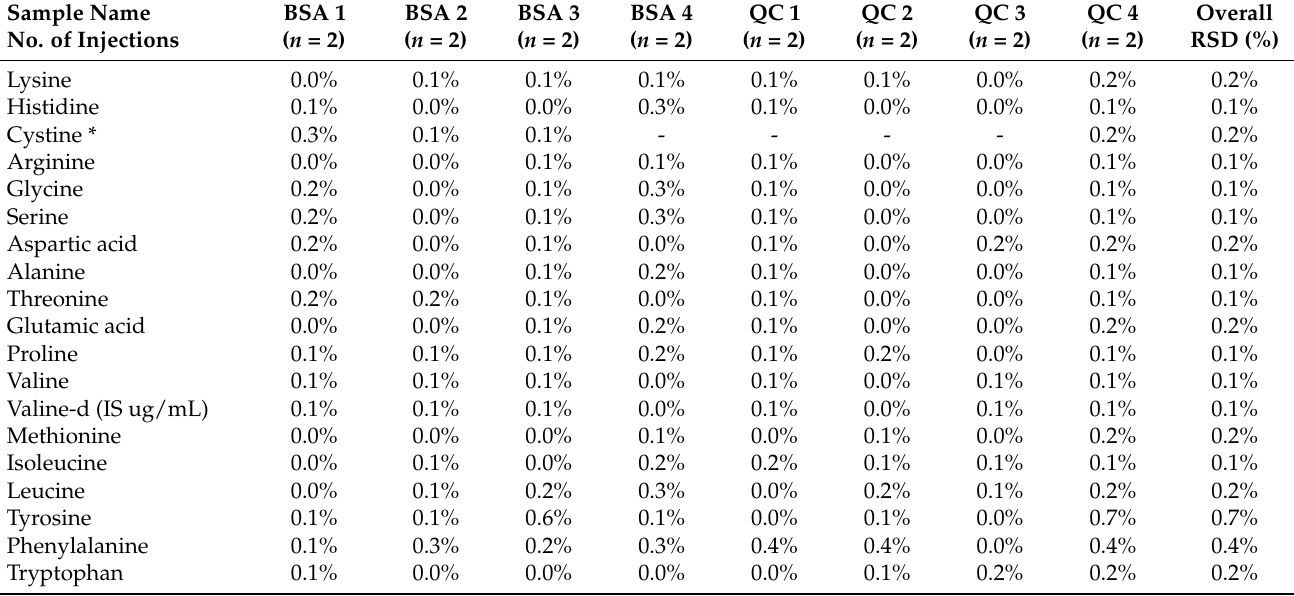
Table 5. The average relative standard deviations (RSD) of retention time 1 of BSA and lentil samples injected two times in four hydrolysis batches on two different matrices (lentil and BSA) analysed over 4